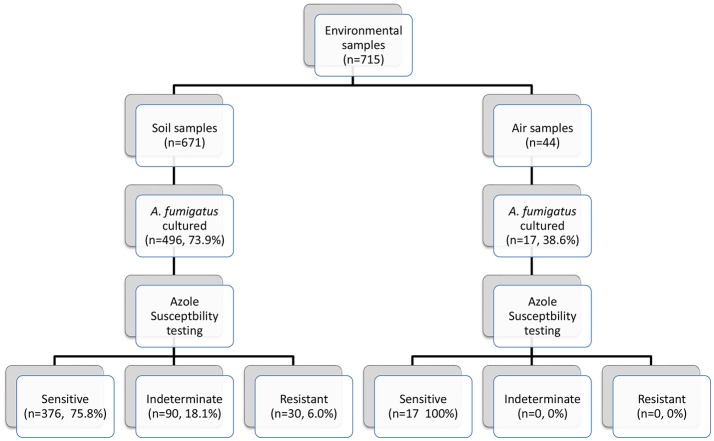
Environmental sampling scheme and breakdown of azole susceptibility testing.